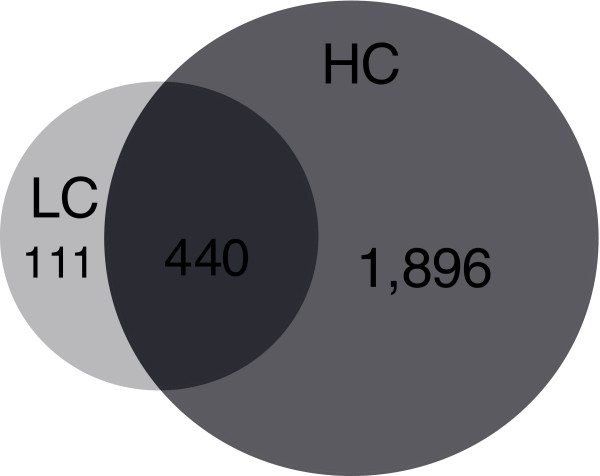
Venn diagram of significantly differentially expressed genes in the LC and HC groups compared to the Con group. ANOVA P < 0.01 and FDR (predicted) <0.05 resulted in 2,846 probesets, and subsequent t-tests with P < 0.01 for HC versus Con and/or LC versus Con resulted in the 2,447 probesets shown.